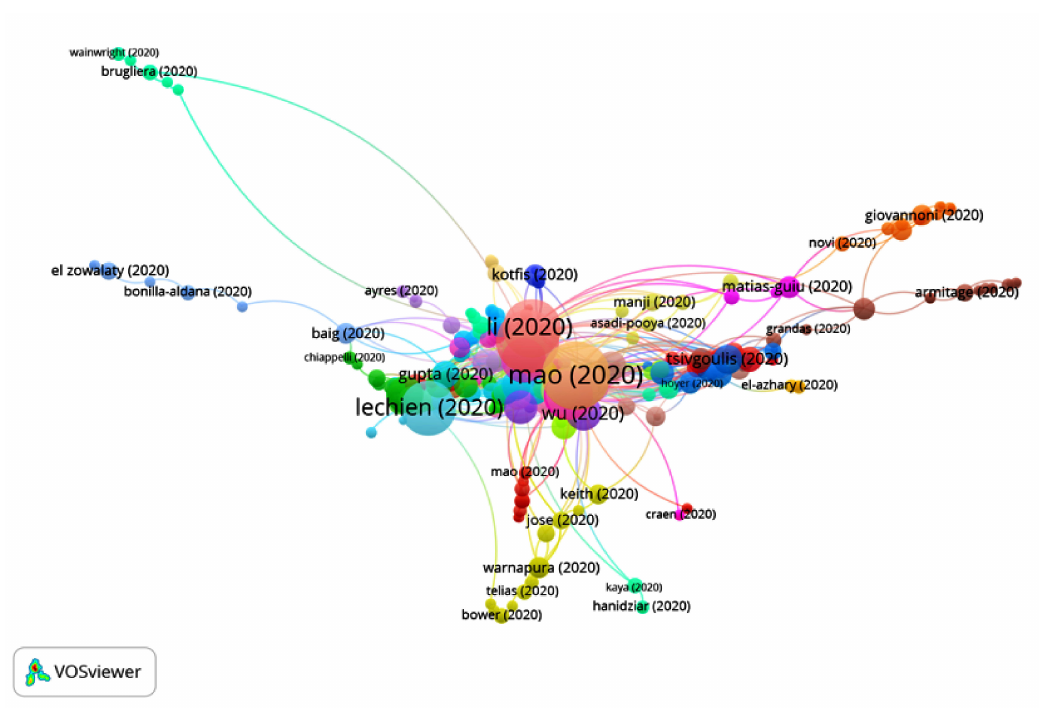
Figure 11. Citation network for Group